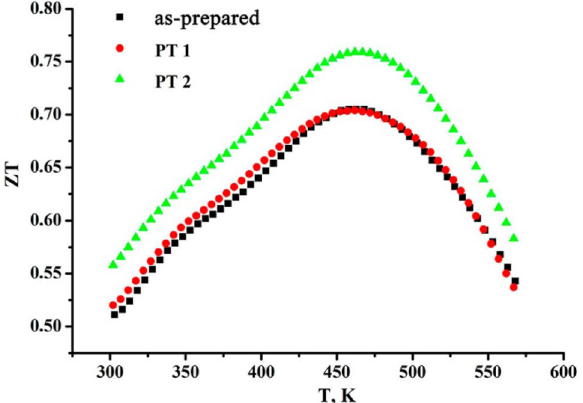
Fig. 7 Temperature dependence of the thermoelectric figure of merit before (as-prepared curve), after the single PT (PT1 curve) and dou- ble PT (PT2 curve) of the studied samples